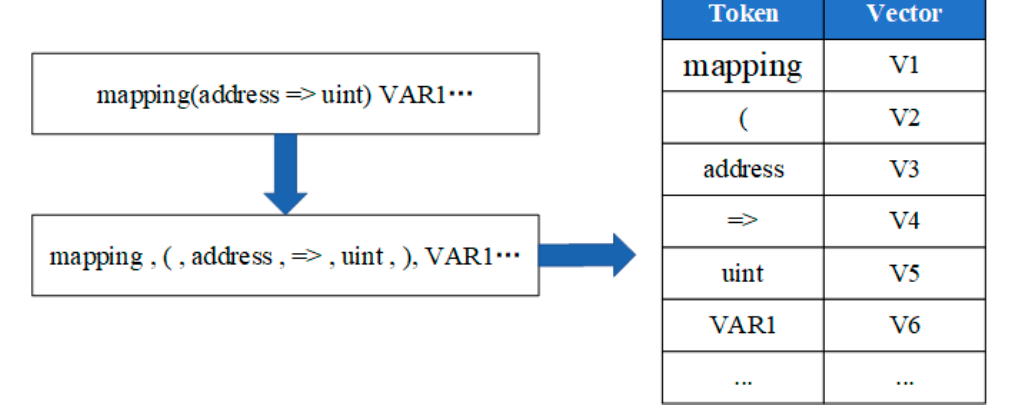
Figure 9. Smart Contract Processing One.